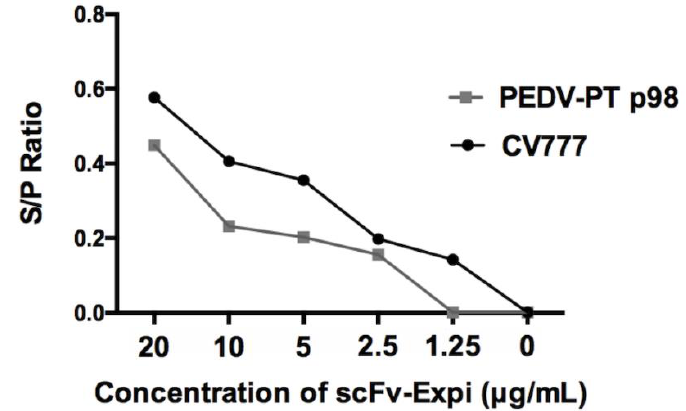
Figure 4. Evaluation of scFv binding toward PEDV virions by ELISA. The virions of PEDV-PT (G2